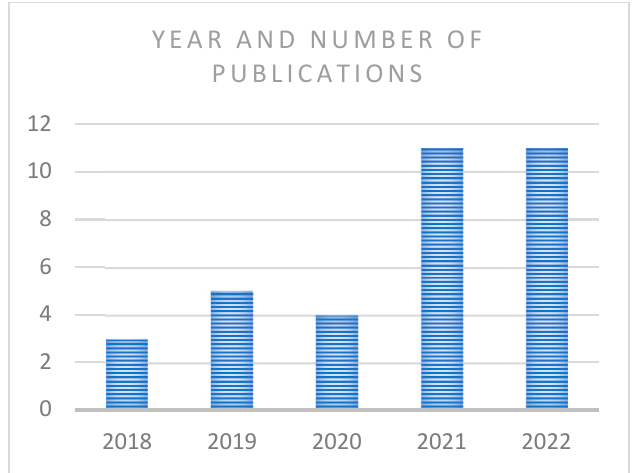
Figure 2. Years and number of publications.